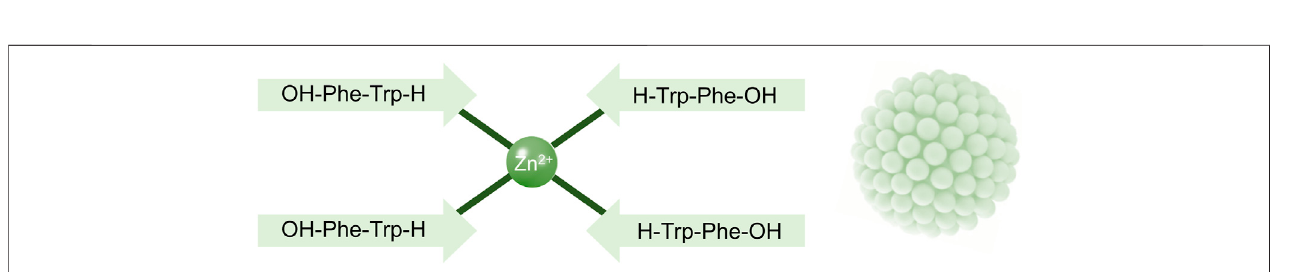
FIGURE 9 | Fluorescent dipeptide nanoparticles DNPs obtained from Trp-Phe dipeptides and Zn (II) by Mingjun Zhang (Fan et al., 2016).